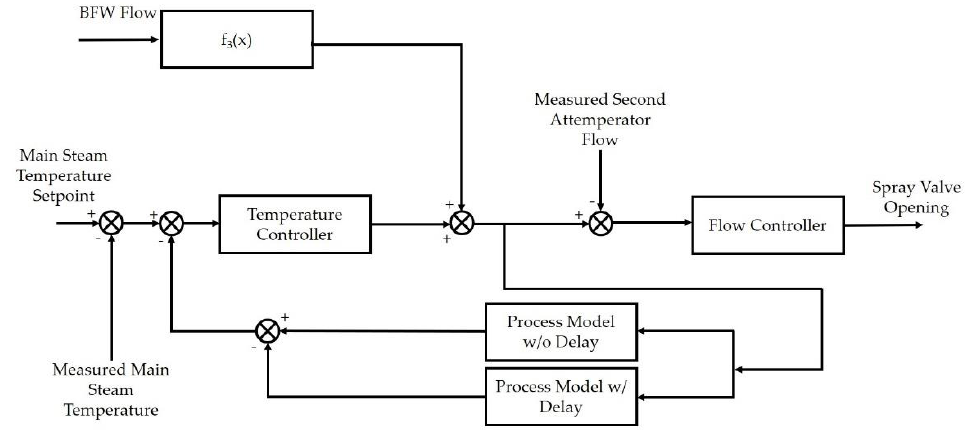
Figure 10. Configuration 3 (Smith Predictor) Control Scheme for Main Steam Temperature.